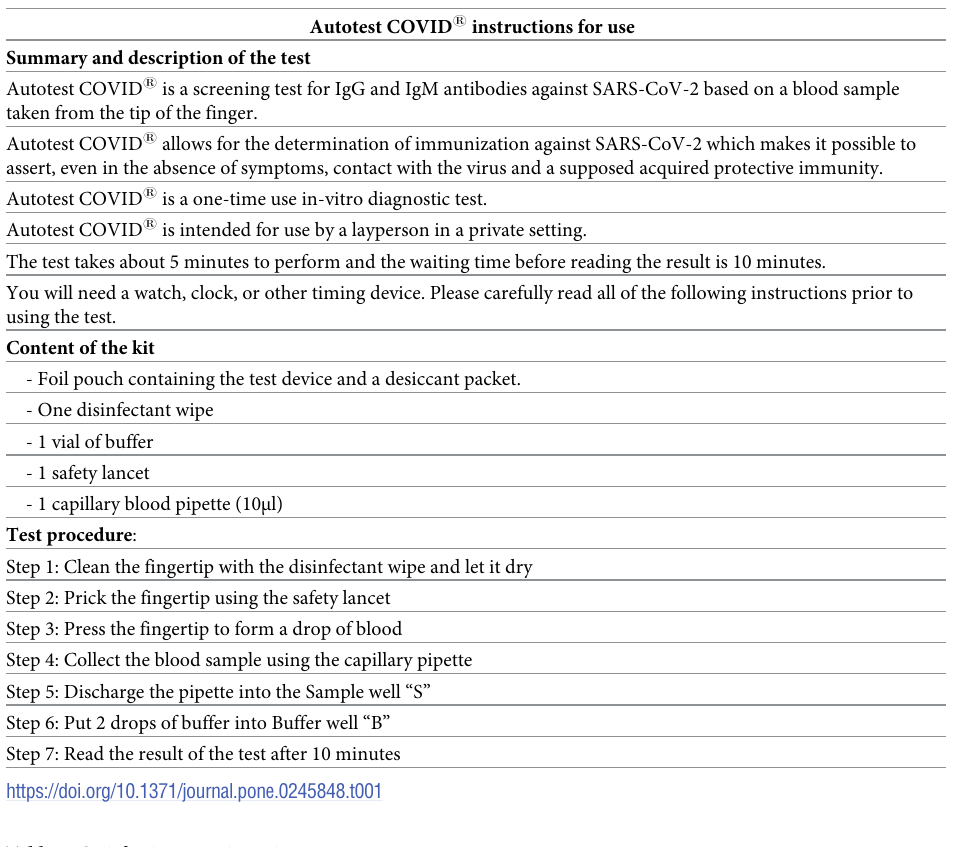
Autotest COVID 1 instructions for use